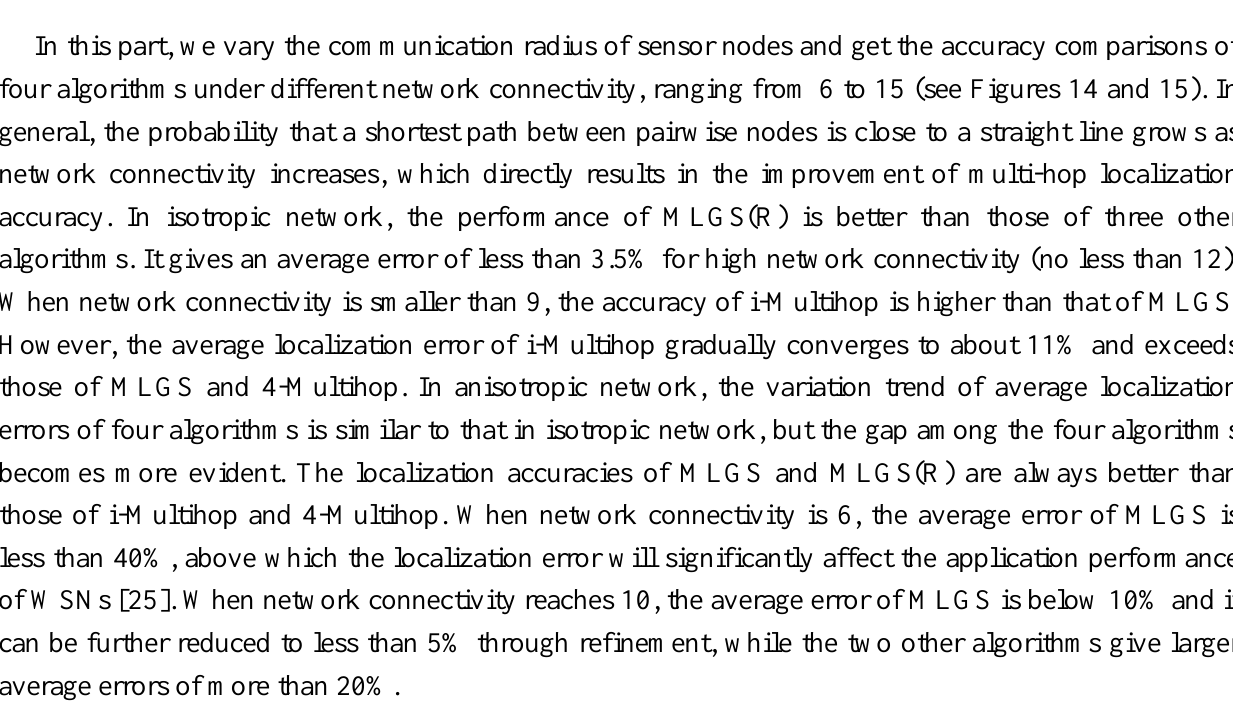
Figure 14. Average Localization error versus network connectivity (isotropic